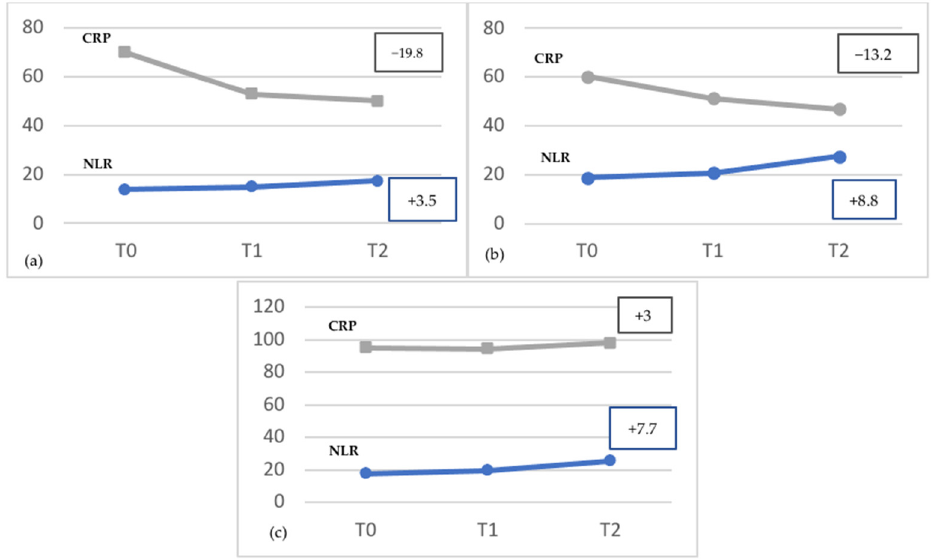
Figure 6. Time course of mean values of NLR and CRP in the total sample ( a ), in deceased patients